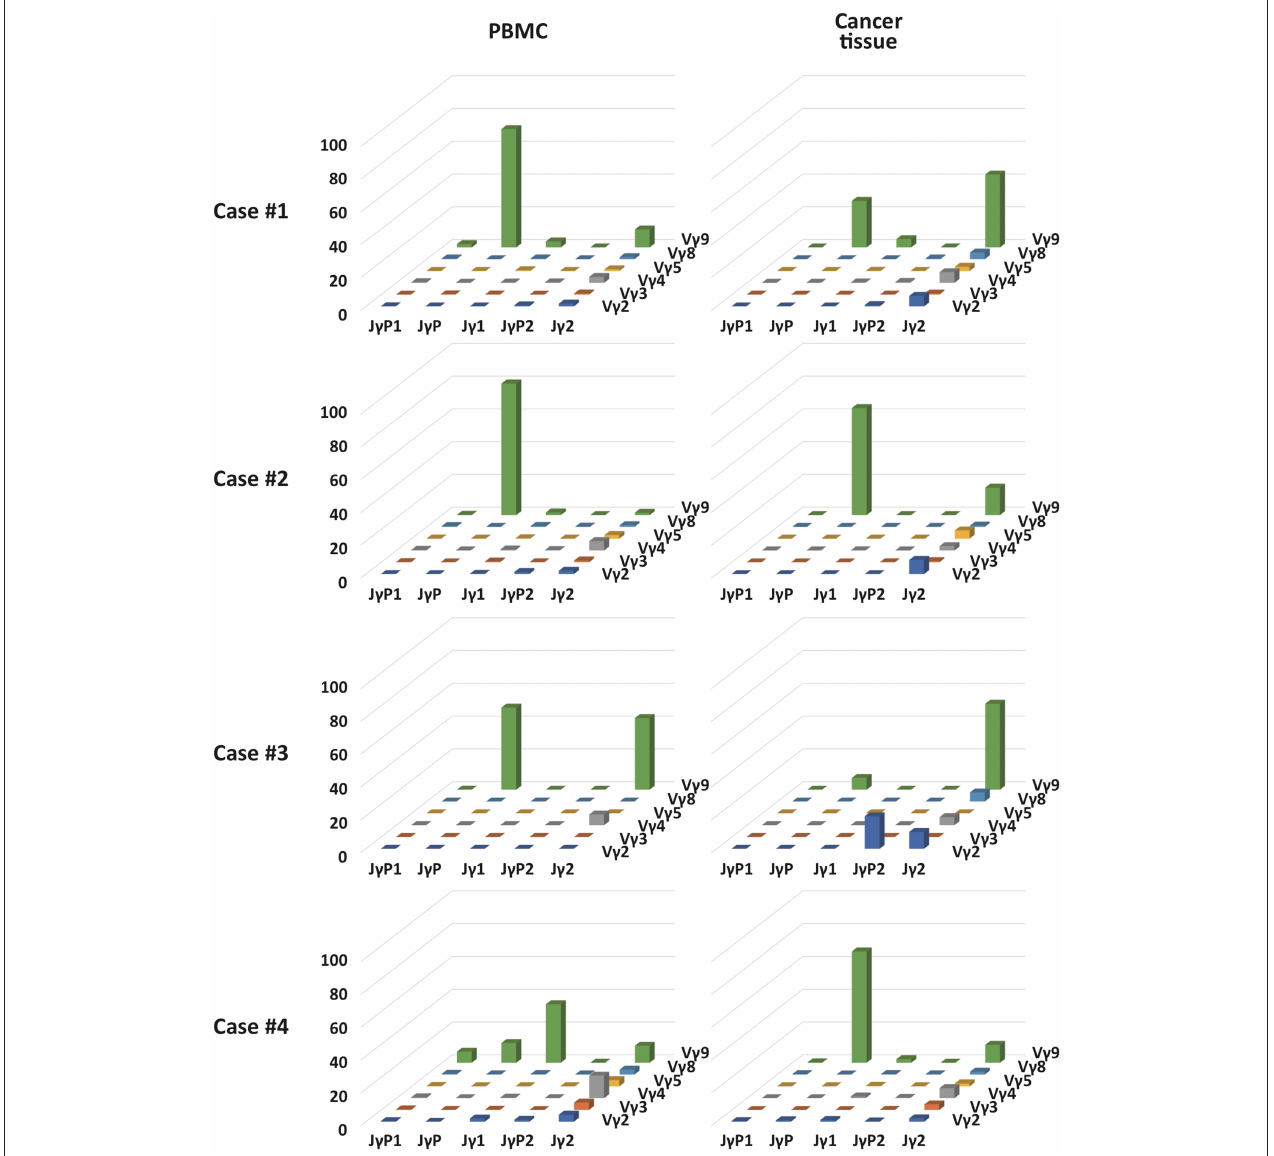
FIGURE 4 | The relative proportion of each combination of V γ and J γ segments in γδ T cells in blood and GBM tumor tissue samples of four patients. 3D graphs show the relative percentages of combinations of V γ -J γ usages in PBMCs or GBM tumor tissues from four